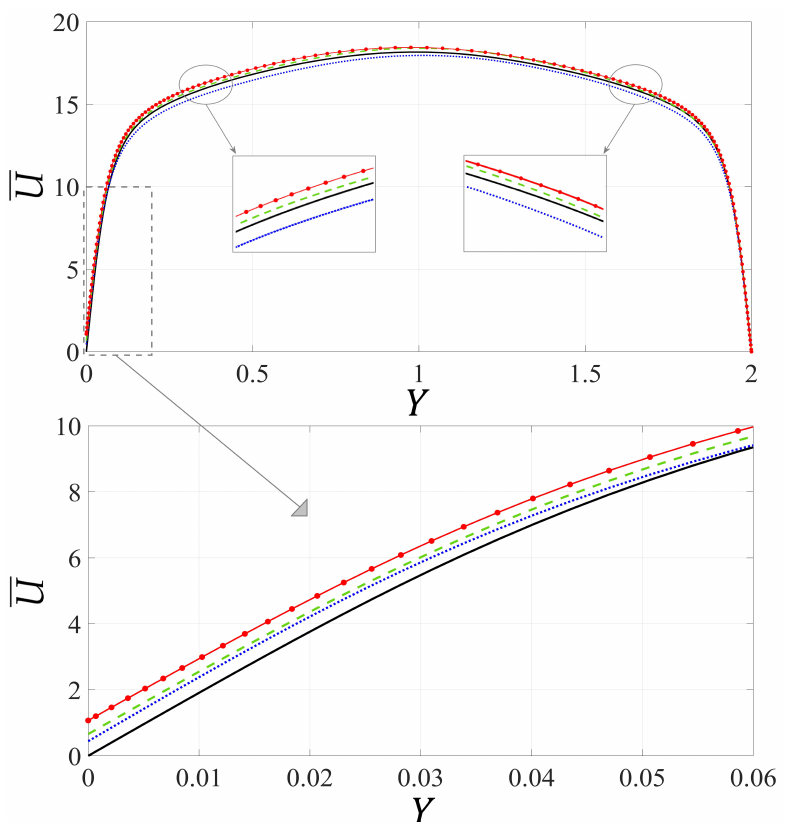
Figure 12. Mean streamwise velocity profiles plotted from the virtual interface between the channel flow and the porous bed ( Y = 0) to the upper no-slip wall ( Y = 2). The cases shown are: (solid black line) smooth channel; (dotted blue line) substrate TC 5 ; (dashed green line) substrate LC 5 ; (red line with markers) substrate LM 5 .